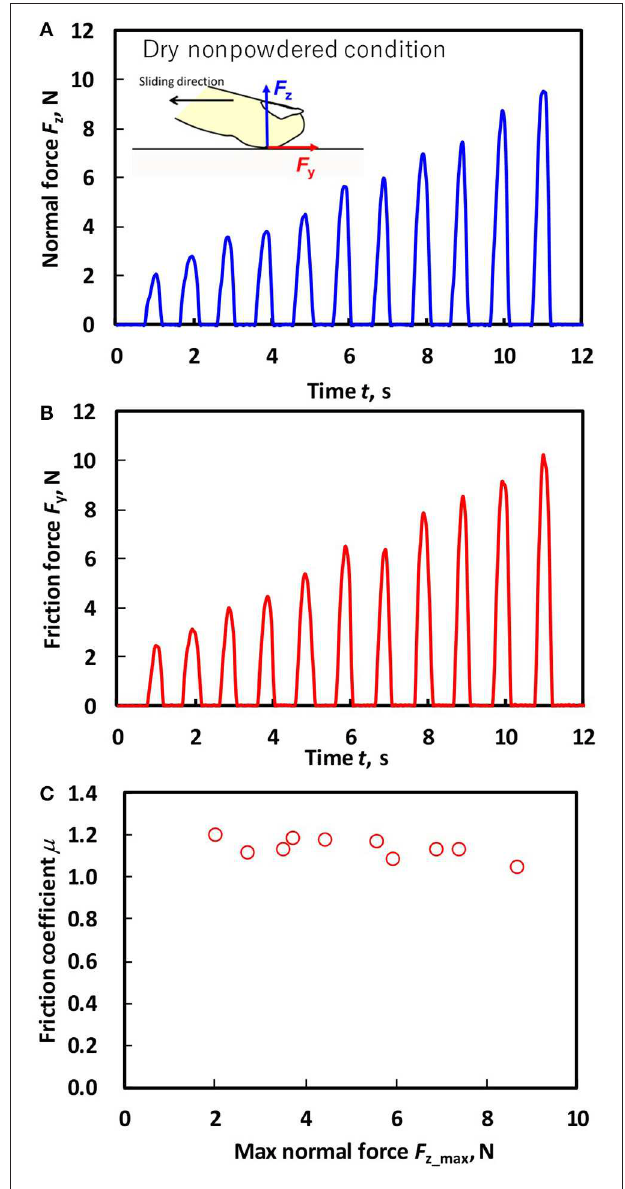
FIGURE 3 | Representative time series of (A) the normal force ( F z ), (B) the horizontal reaction force ( F y ), and (C) the friction coefficient ( µ ) under the dry non-powdered condition during the low normal force condition ( F z ≤ 10N) for participant B.